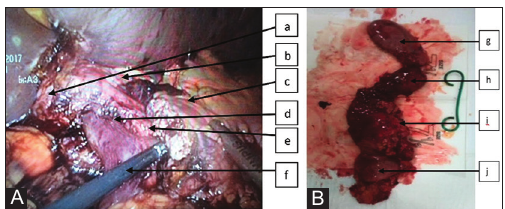
FIGURE 2. (A) Surgical field after resection: (a) Common hepatic duct; (b) common hepatic artery; (c) body of pancreas; (d) portal vein; (e) lienal vein; and (f) superior mesenteric vein. (B) Surgical resected organs: (g) Gallbladder; (h) choledoch duct; (i) head of pancreas; and (j)